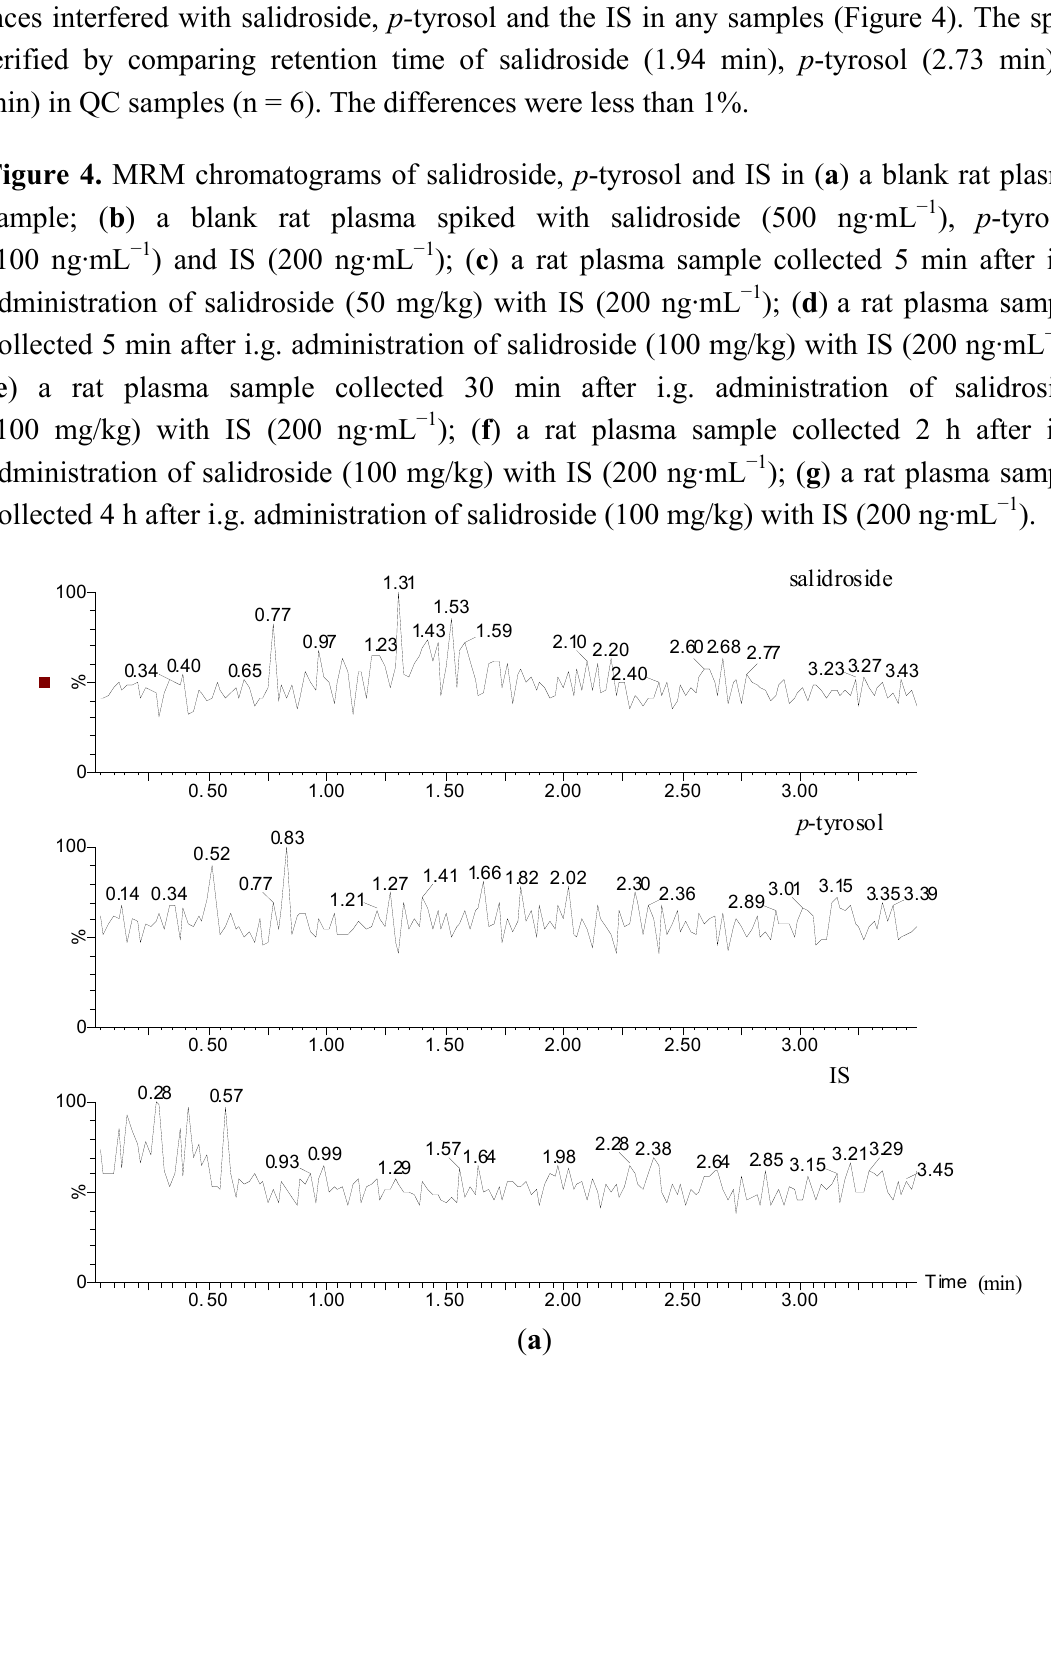
Figure 4. MRM chromatograms of salidroside, p -tyrosol and IS in ( a ) a blank rat